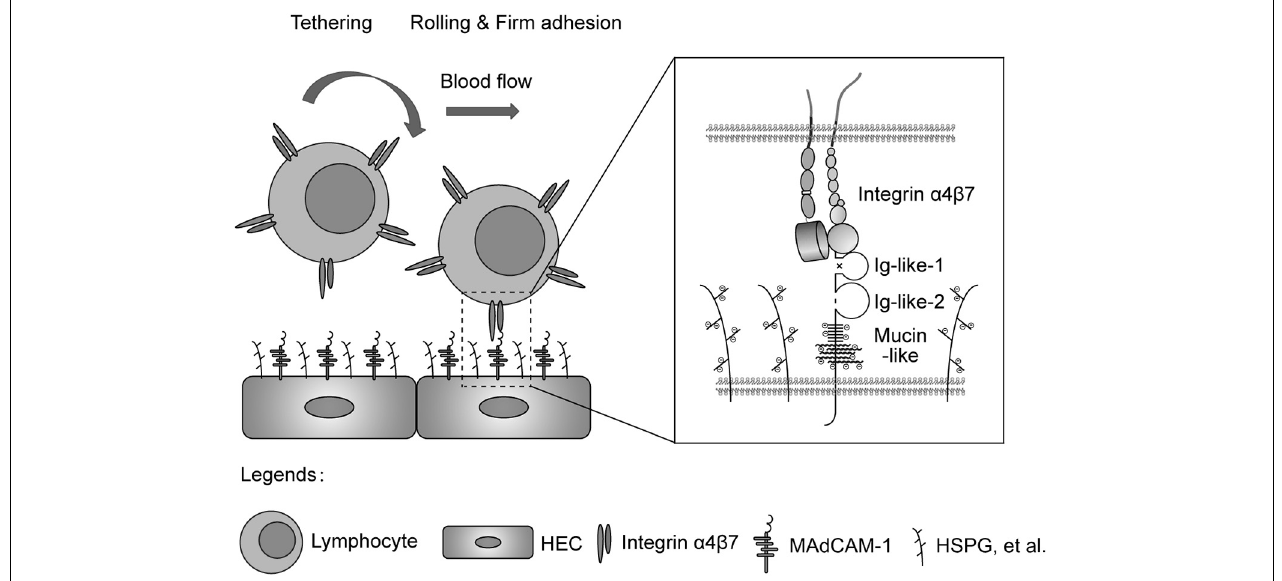
FIGURE 6 | Electrostatic repulsion between mucin-like domain and negative charges of the extracellular microenvironment facilitates integrin α 4 β 7-mediated cell adhesion. Schematic diagram of the adhesion of lymphocytes from blood to the endothelium of HEVs in gut-associated lymphoid tissues. HEC, high endothelial cell; HSPG, heparan sulfate